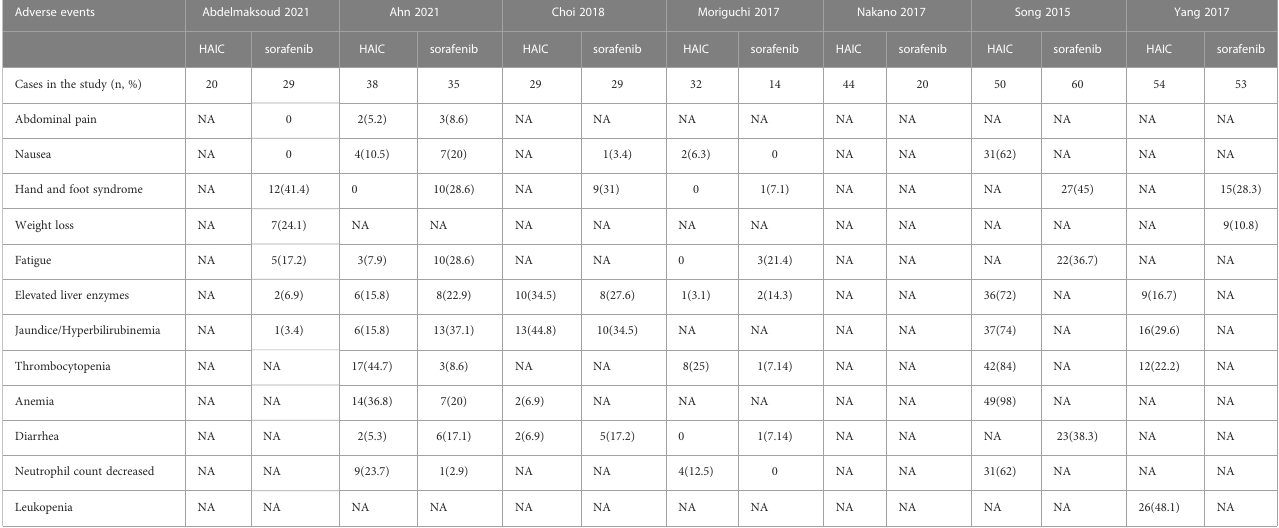
TABLE 4 Adverse Events Related to Treatment.